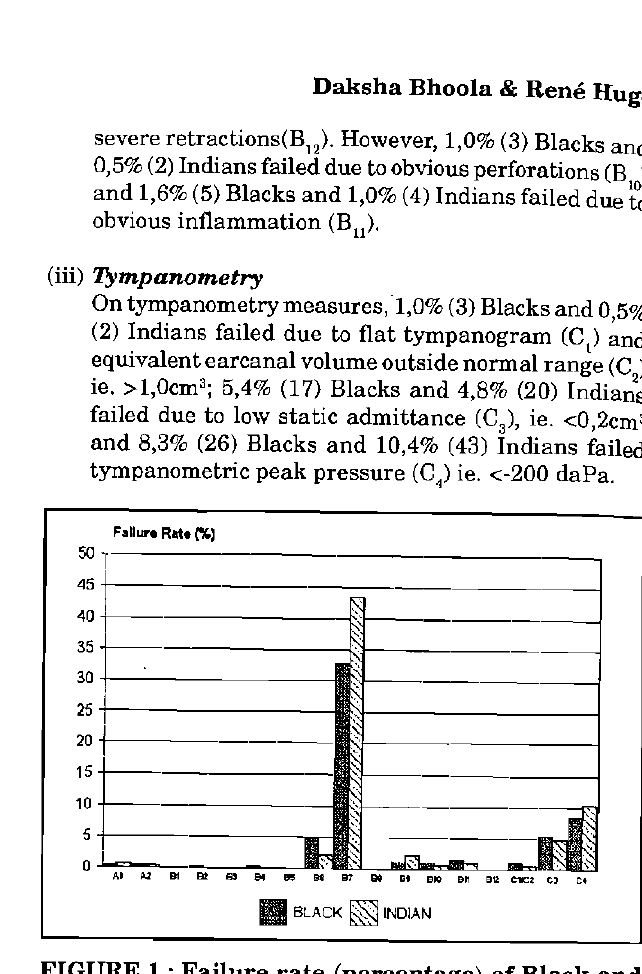
FIGURE 1 : Failure rate (percentage) of Black and Indian subjects within each category of the MESP TABLE 2 : Failure rate (percentage and numbers) of Black and Indian subjects within each category of the Middle Ear Screening Protocol (MESP) Middle Ear Screening Protocol